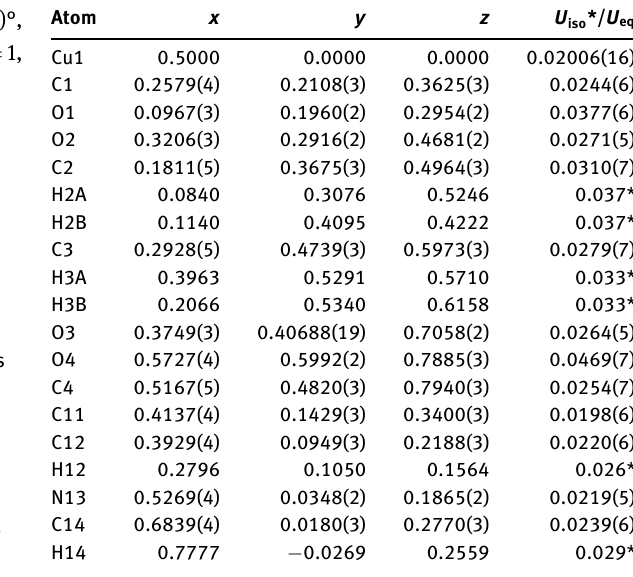
Table 2: Fractional atomic coordinates and isotropic or equivalent isotropic displacement parameters (Å 2